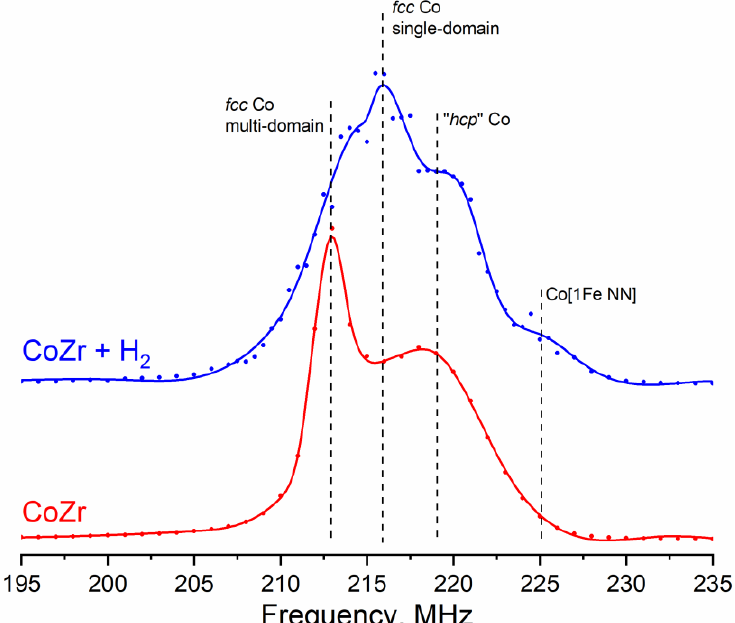
Figure 9. 59 Cо Internal Field NMR spectra of the Co-Zr mechanical alloying product (red) and the product of hydrogen treatment (blue). Experimental points are shown with symbols, solid lines show the interpolation curves. Approximate positions of signals corresponding to different cobalt structures are marked with dashed lines. 59 Co Internal Field NMR spectra. Thus, in sufficiently large particles divided into magnetic